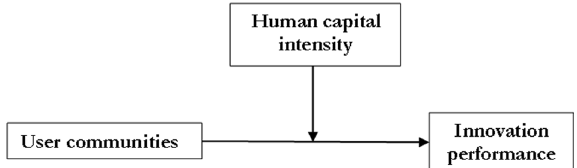
Fig. 3 Moderation effect